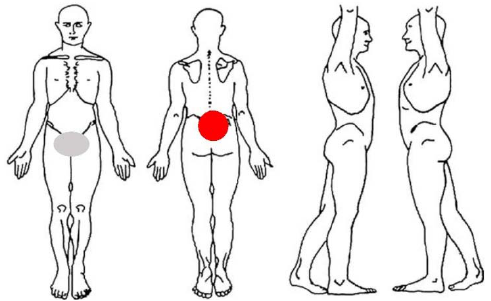
Figure 2. Body chart. Red circle indicates pain; grey circle indicates dysesthesia.